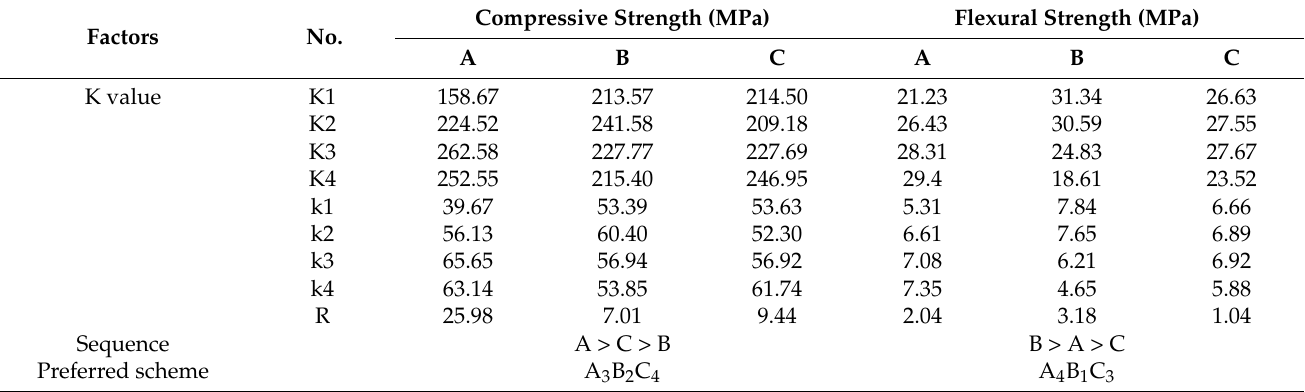
Table 8. Analysis results of the polar differences in the mechanical properties of the K-based geopoly- mers at 28